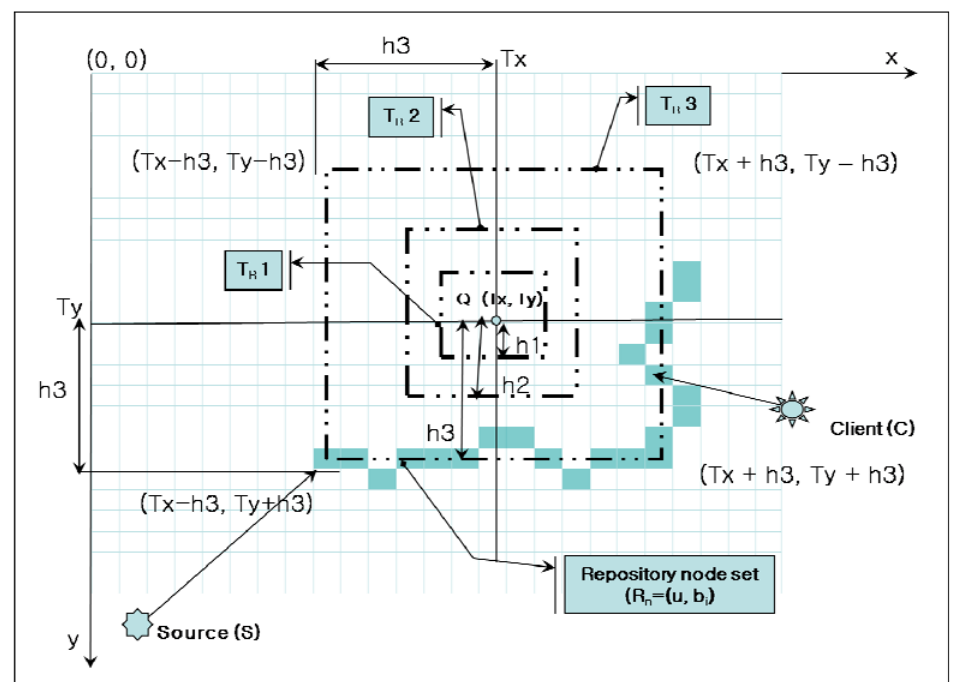
Figure 7. Dynamic Trajectory Development.